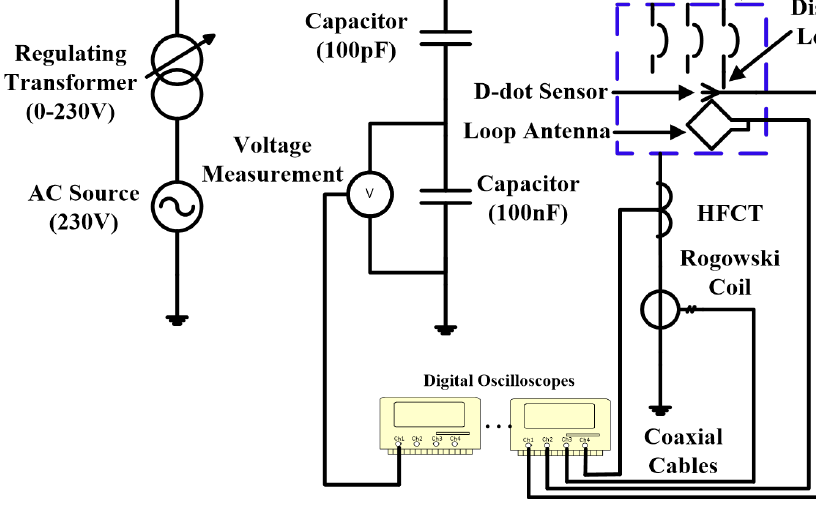
Figure 9. PD test setup.